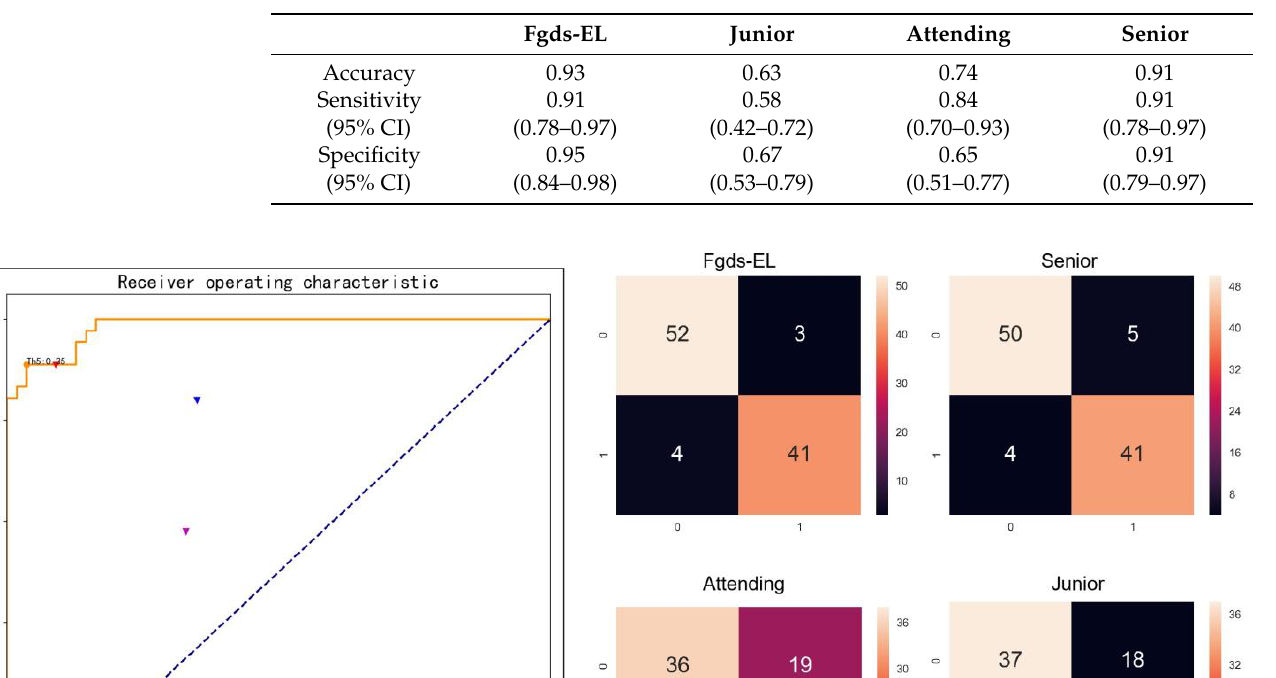
Table 4. The screening performance of the Fgds-EL model and three sonographers.